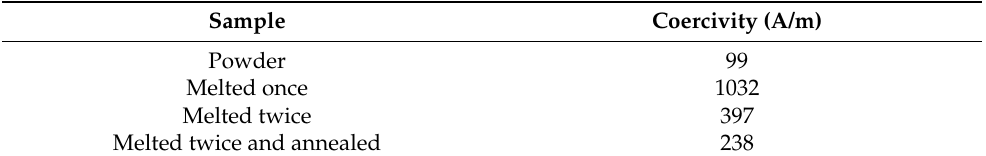
Table 2. Coercivity of feedstock powder and melted samples of Fe 71 Si 10 C 6 Cr 2 (at.%) alloy (reprinted with the permission from [76], Elsevier, 2019).